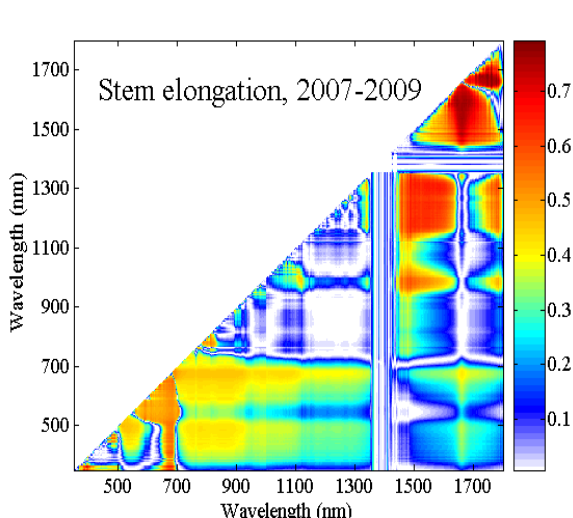
Figure 4. Contour diagram showing the coefficient of determination (R²) for the linear relationship between AGB and